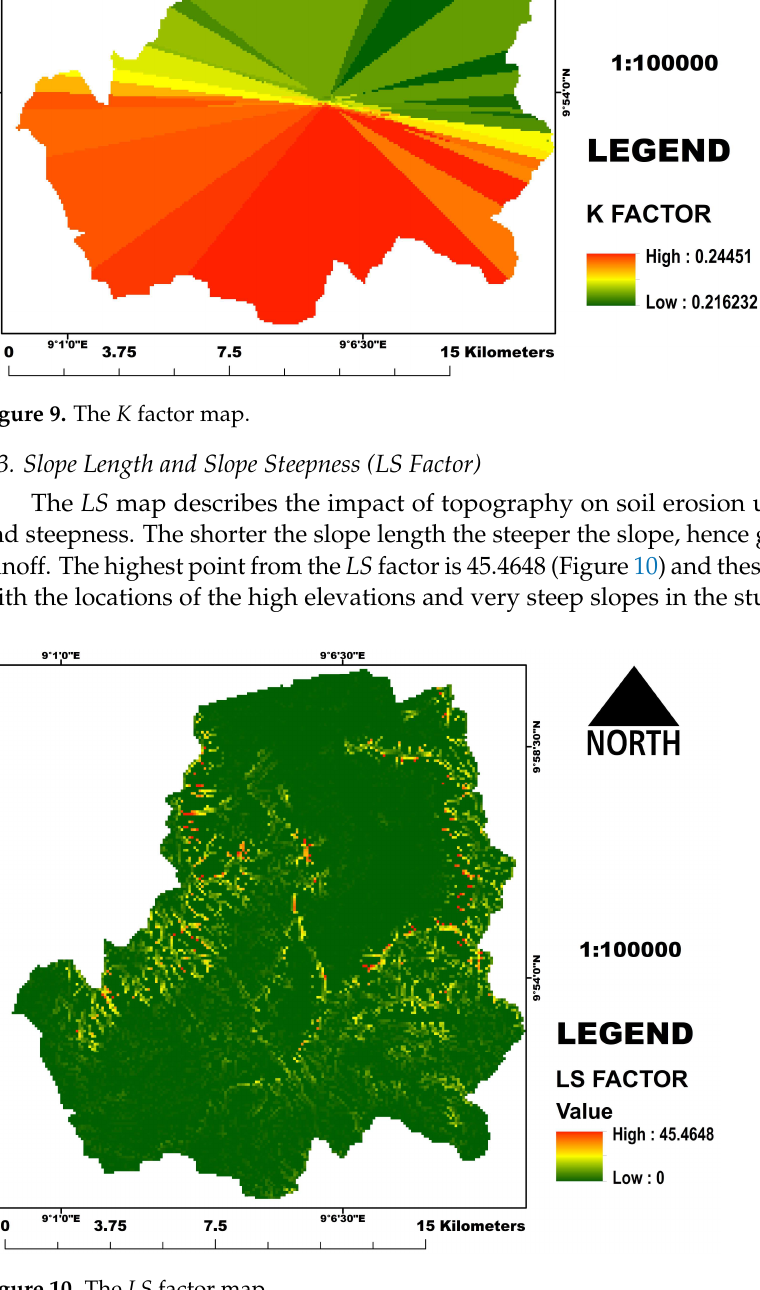
Figure 10. The LS factor map.